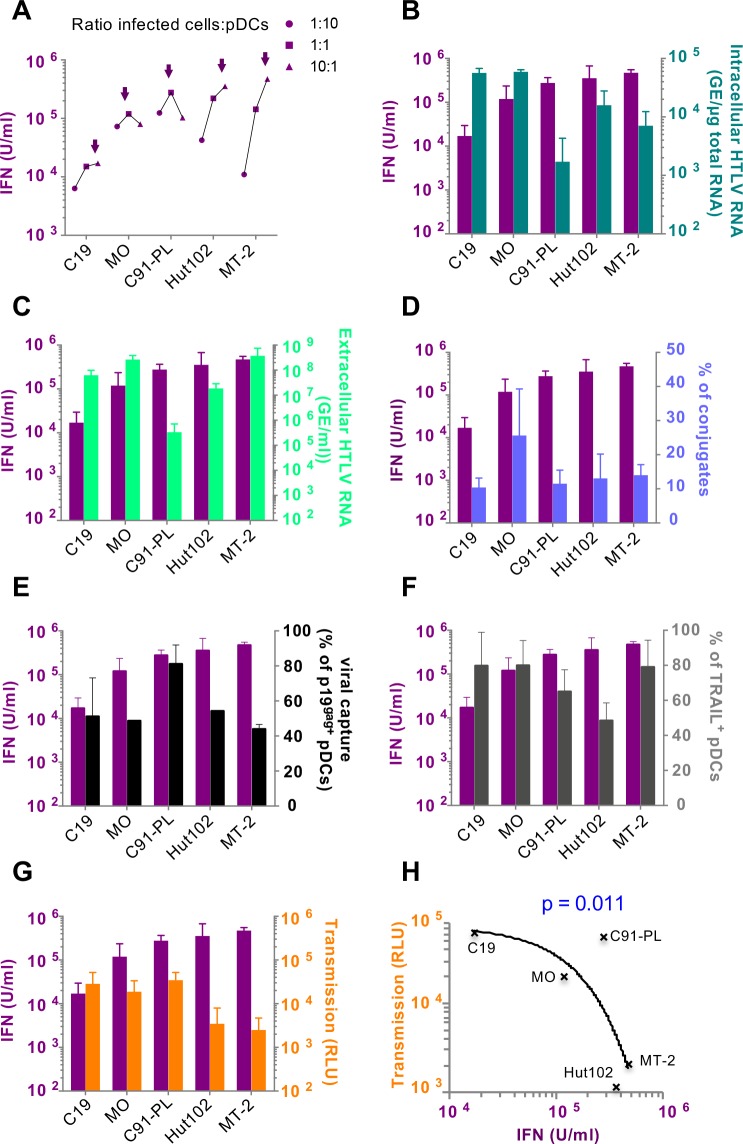
Levels of pDC IFN-I production triggered by HTLV infected cells inversely correlate to the efficiency of infectious viral transmission via cell-cell contact.A. IFN-I activity levels were quantified after co-culture of increasing number (2x103; 2x104; 2x105) of HTLV-1 (C91-PL; Hut102; MT-2) or HTLV-2 infected cells (C19; MO) with pDCs (2x104). The infected cells:pDC ratio is indicated on the right of the graph. Arrows indicate the maximum level of IFN-I activity for each cell line setting (mean of 3 independent experiments). B-G. Parallel representation of the maximum levels of IFN-I activity induced after co-culture of pDCs with HTLV-infected cells and of (B) intracellular viral RNA present in the cytoplasm of HTLV-infected cell lines (mean ± SD; 3 independent experiments); (C) viral RNA released in the supernatant of HTLV-infected cell lines after 24h of culture (mean ± SD; 3 independent experiments); (D) the percentage of cell contacts established between pDCs and HTLV-infected cells (mean ± SD; 2–4 independent experiments); (E) percentage of viral capture after 4h of co-culture with HTLV-1/2 infected cells as determined by p19gag detection in pDCs (mean ± SD; 3 independent experiments); (F) percentage of TRAIL expression after 24h of co-culture detected on the pDCs surface (mean ± SD; 3 independent experiments) or (G) maximum infectivity levels as determined in S5D Fig (n = 3). H. Correlation curve of pDC-dependent IFN-I production and viral transmission and calculated p value.